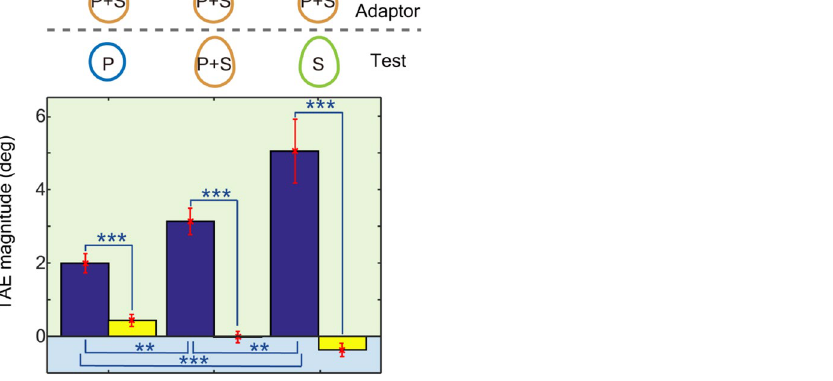
Figure 5. The mean TAE magnitudes across the participants with congruent, synergic adaptors (Exp. 3). The same conventions are used as in Figs. 2 and 4. Blue and yellow bars show the measured TAEs for the three conditions (from the left, TAE P+S,P , TAE P+S,P+S , and TAE P+S,S ) and those for the corresponding blank conditions, respectively. Error bars show the standard error (SEM), and asterisks denote statistical significance (*p < 0.05; **p < 0.01; ***p <